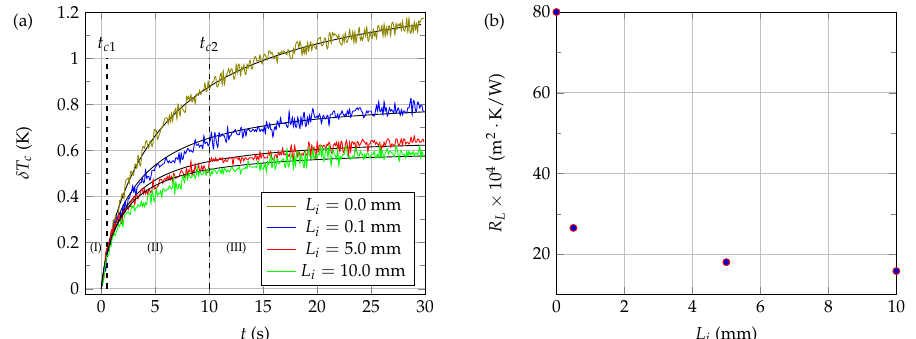
Figure 15. Influence of the immersion length L i on the self-heating of NTC3 immersed in glycerol at rest, at a working temperature T 0 = 25.0 ◦ C. A constant excitation voltage v 0 = 6.90 V was used to heat the NTC. ( a ) Active core temperature evolution as a function of time and length L i . The solid black curves correspond to the results given by the 1D electro-thermal systemic modeling while the colored curves correspond to the experimental data. ( b ) Evolution of the loss resistance R L as a function of the immersion length L i